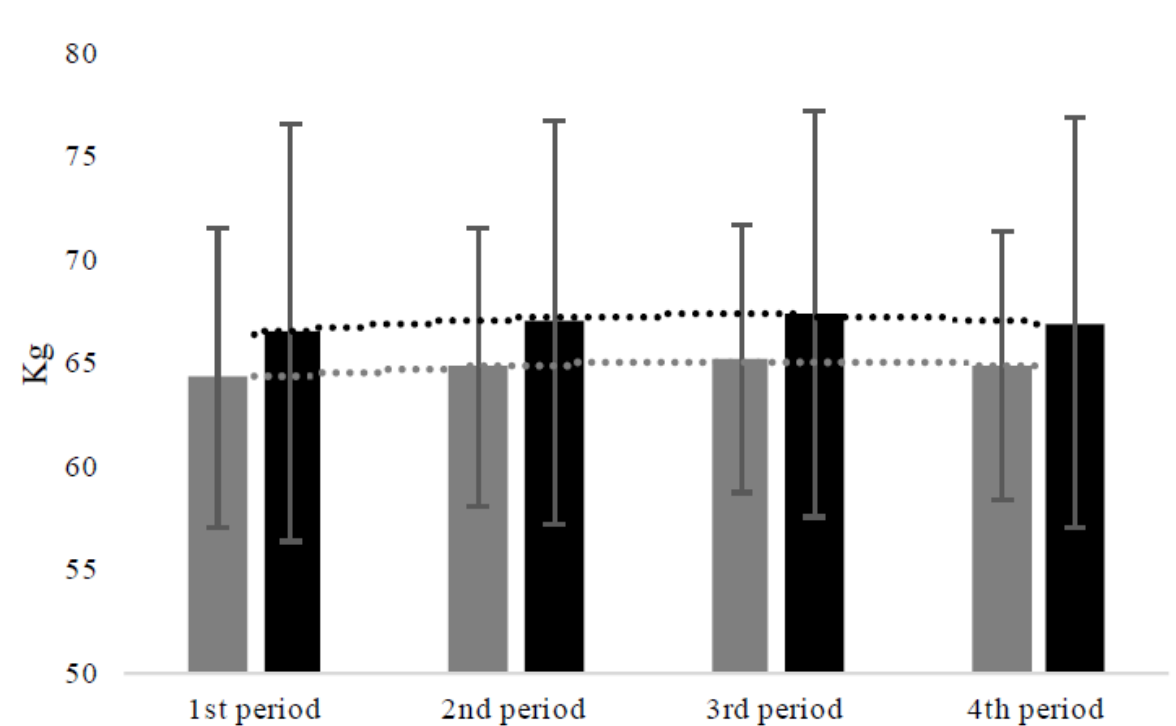
Figure 1. Variation of body weight according to the time of the study and type of intervention, with just a significant time effect, according to the linear mixed models analysis. Note: Grey columns, non-exercising women; black columns, exercising women; 1st period (i.e., the period not including government restrictions), from 3 February 2020 to 8 March 2020;